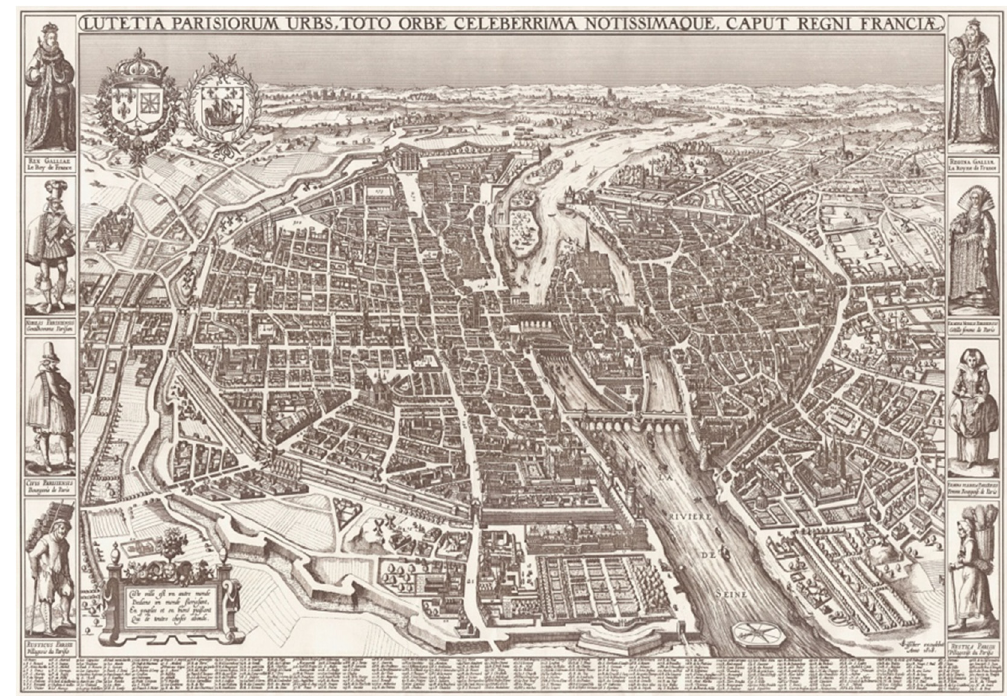
Figure 1. Hand-drawn perspective map by Claes Janszoon Visscher (http://en.wikipedia.org/wiki/Pictorial_maps).